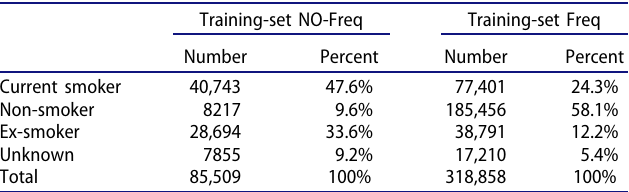
Table 2. Training-set class distribution.